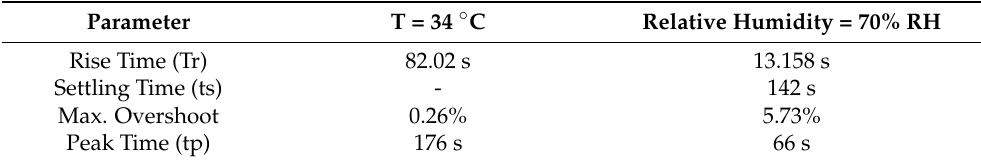
Table 4. Characteristics of the system response to set point temperature 34 ◦ C and humidity 70%.